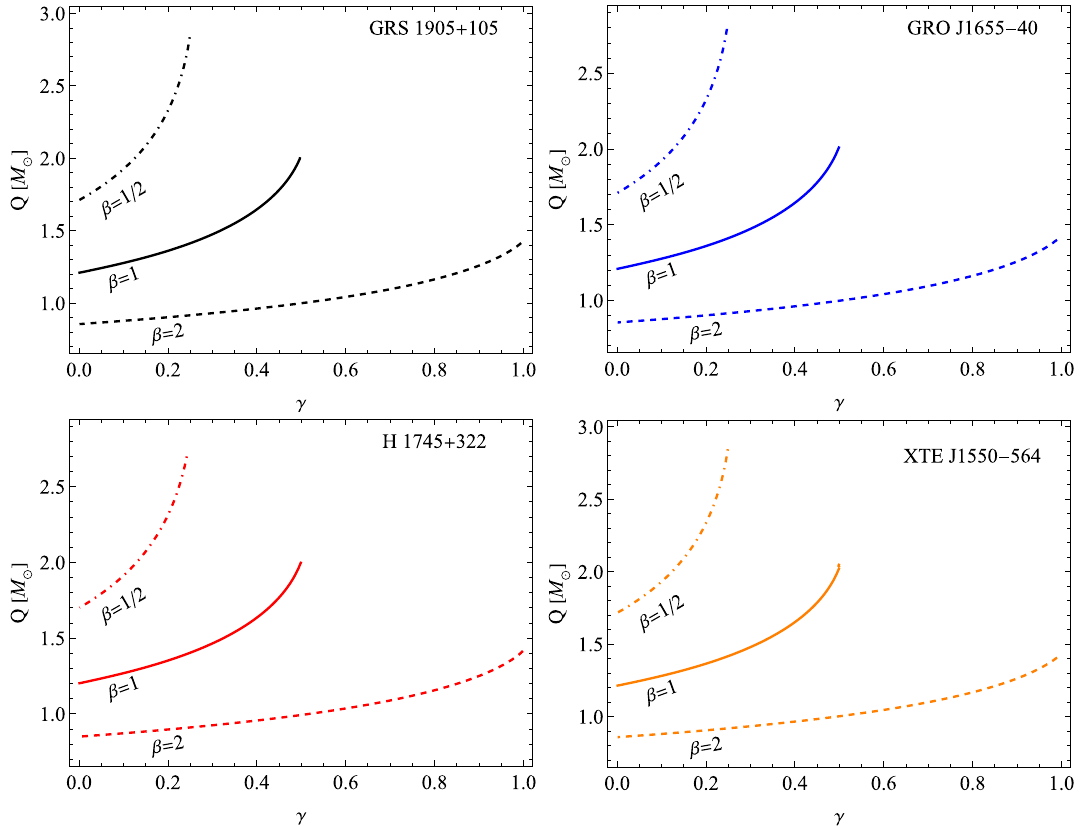
Fig. 15 Relationships between BH charge and the parameter γ of the spacetime around the BHs in the microquasars GRS 1905+105, GRO J 1655-40, H 1745+322 and XTE 1550-564 for fixed values of